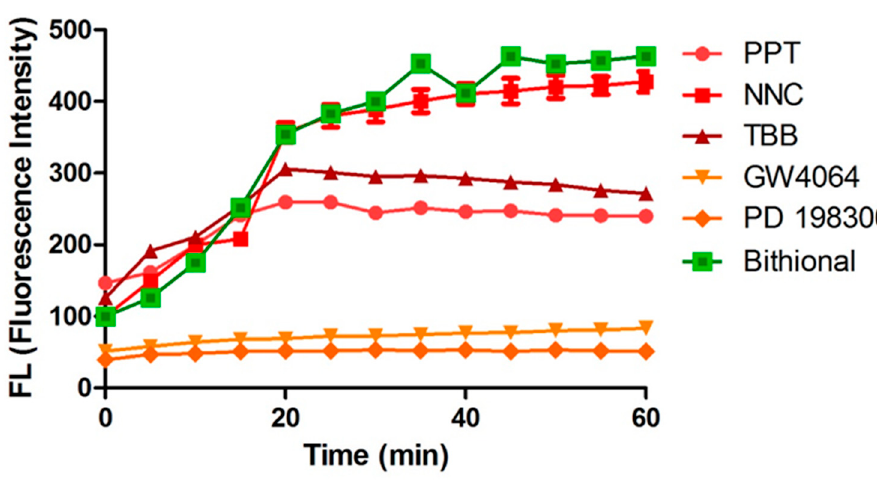
Figure 4. Cellular fluorescence of MRSA-MW2 cells treated with sytox green and test compounds (64 µg/mL) monitored over 1 hr. Bithionol (64 µg/mL) was included as positive control.